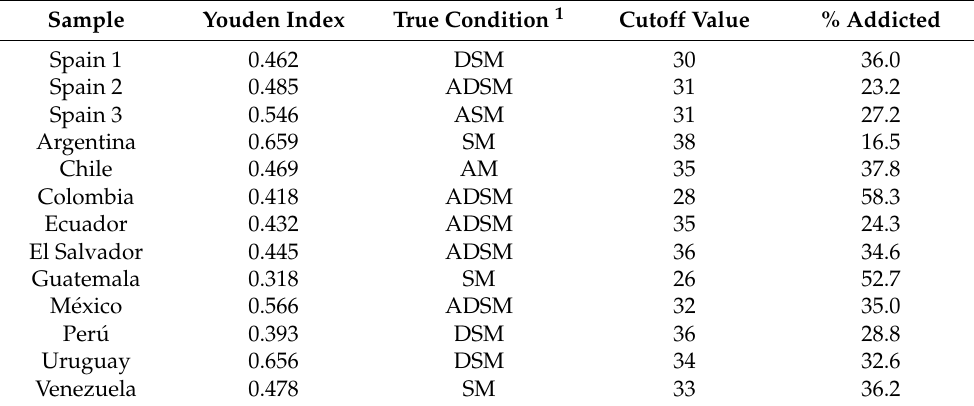
Table 5. True conditions, cutoff values, and percentage of ‘addicted’ youth when highest Youden Index is used as the decision rule.